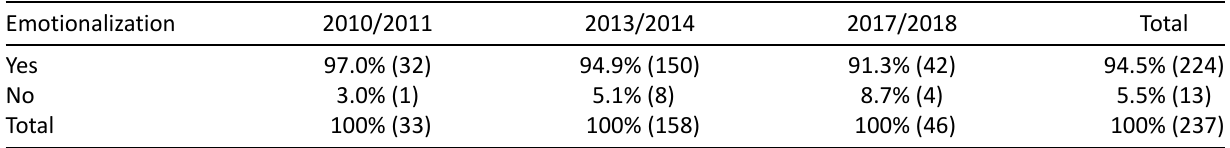
Table 5. Emotionalization over time.